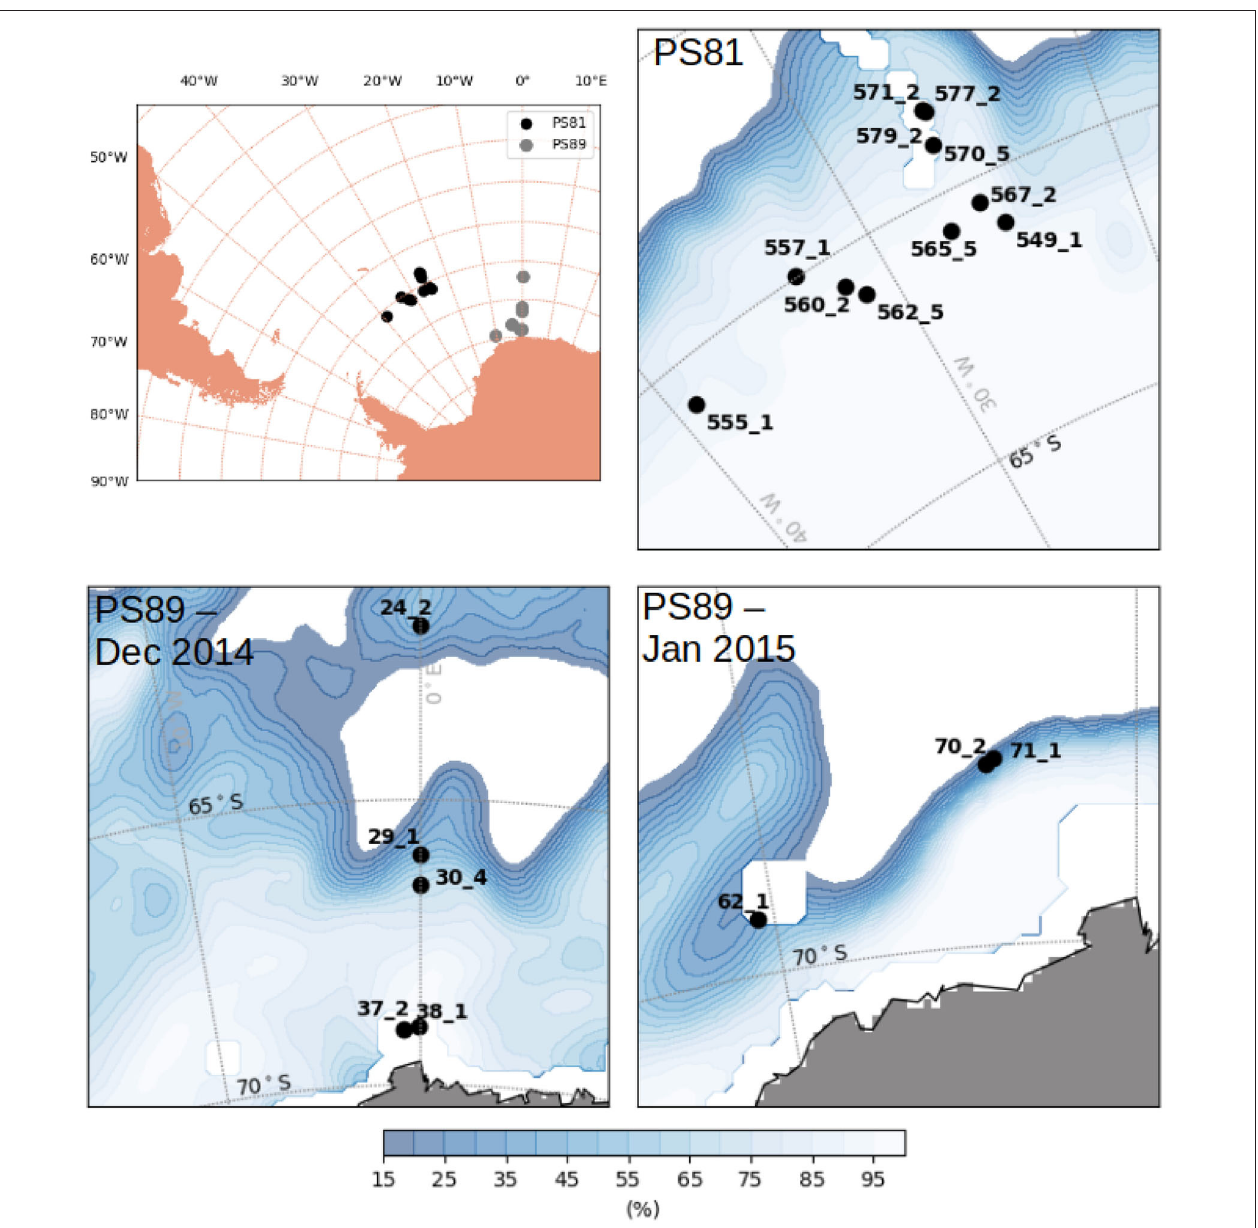
FIGURE 2 | Map of the Antarctic with stations carried out during PS81 (winter 2013) and PS89 (summer 2014/2015). Ice concentration averaged over the period of sampling of each expedition was taken from OSISAF (EUMETSAT, 2011).